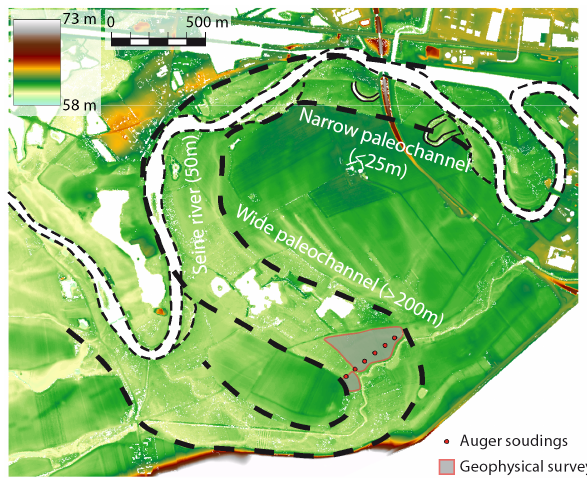
Figure 2. Lidar map of the study area, showing the contemporary location of the Seine River, together with the narrow and wide pa- leochannel